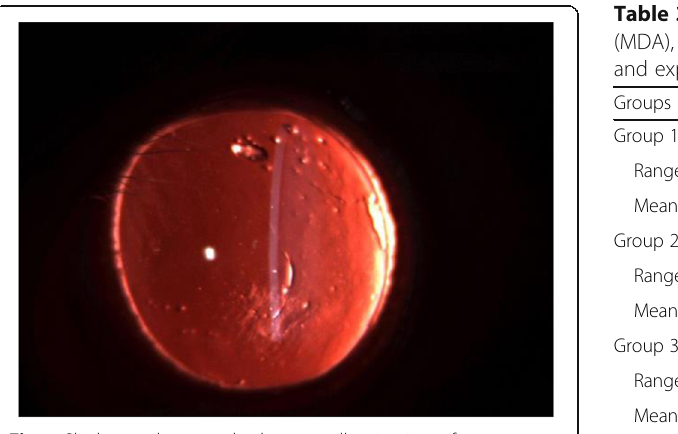
Fig. 5 Slit lamp photography by retro illumination of group 5 (diabetic model treated with TMAO) showing water vacuoles inside the lens